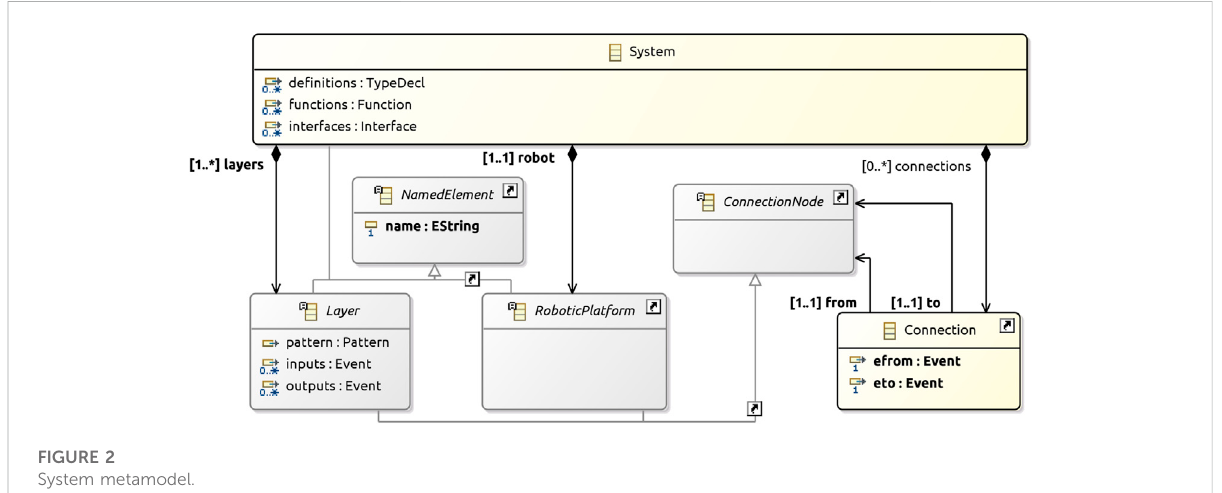
FIGURE 2 System